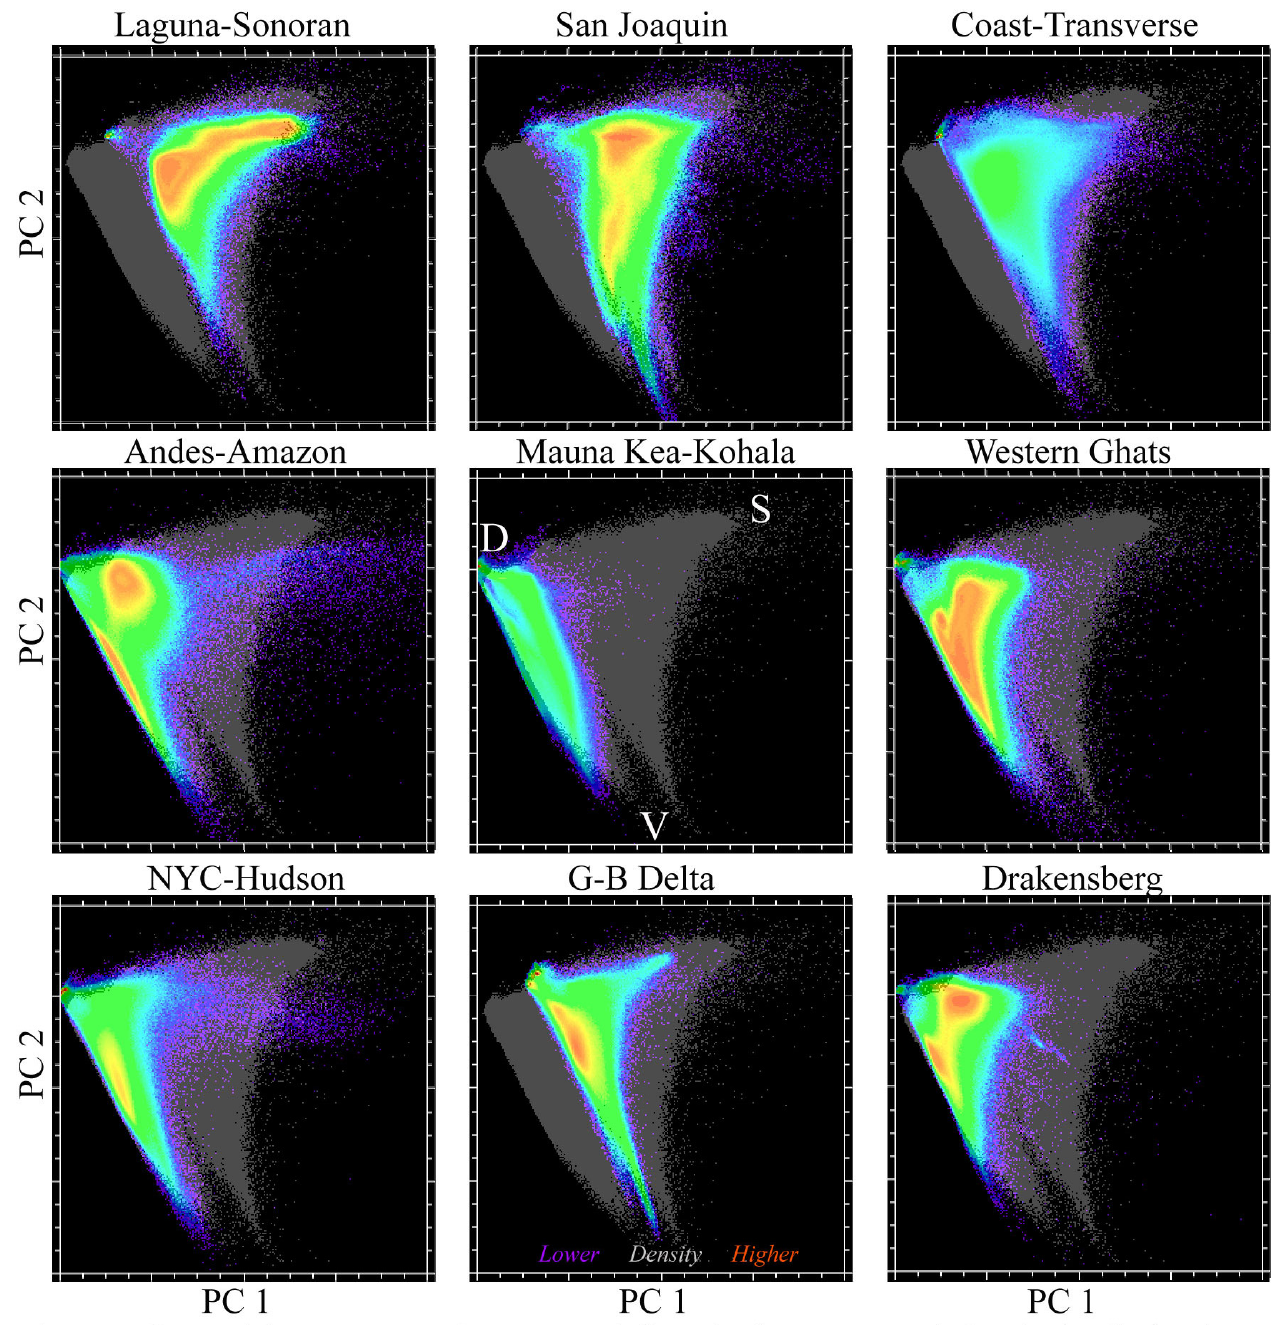
Figure 3. Spectral feature spaces for 9 spectral diversity hotspots. Each Sentinel 2 tile has been projected onto the silhouette of the 9-site composite space in Figure 2 using the composite rotation parameters. In each space, the trajectory of the vegetation limb is determined by background substrate albedo and vegetation canopy shadow.